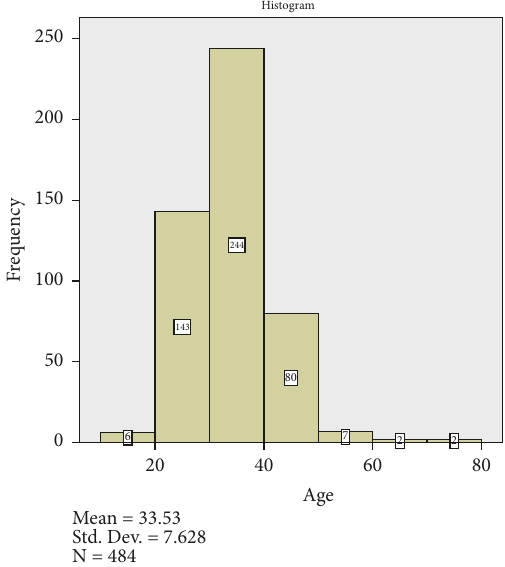
Figure 1: Age distribution of the study population. The age group of 30-40 years account for the highest number of cases.